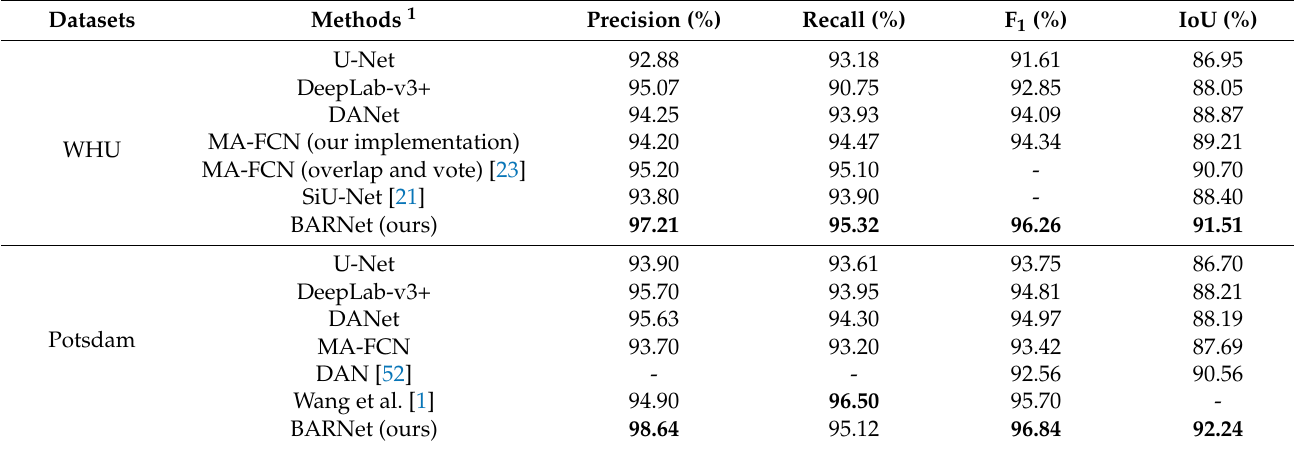
Table 1. Quantitative results of different methods on the two datasets. The entries in bold denote the best on the corresponding dataset. The short line in this table is the unknown results that were not given by the authors.